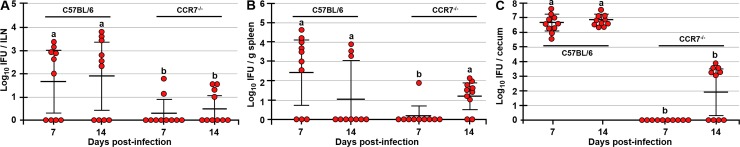
CCR7 signaling is important but not essential for Chlamydia dissemination to the ILNs, spleen, and the GI tract.Chlamydia titers in ILNs (A), spleen (B) and ceca (C) of C57BL/6 (control) and CCR7-/- mice at 7 and 14 dpi PV with 106 IFU of Chlamydia. Chlamydia titers are expressed as log10 number of IFU per ILNs, per g of spleen, or per cecum. Data are representative of two experiments and are expressed as the mean ± SD. Group means were separated using Student’s t-test (n = 10 mice per time point). Group means that do not share a superscript are significantly different from each other (p<0.05).